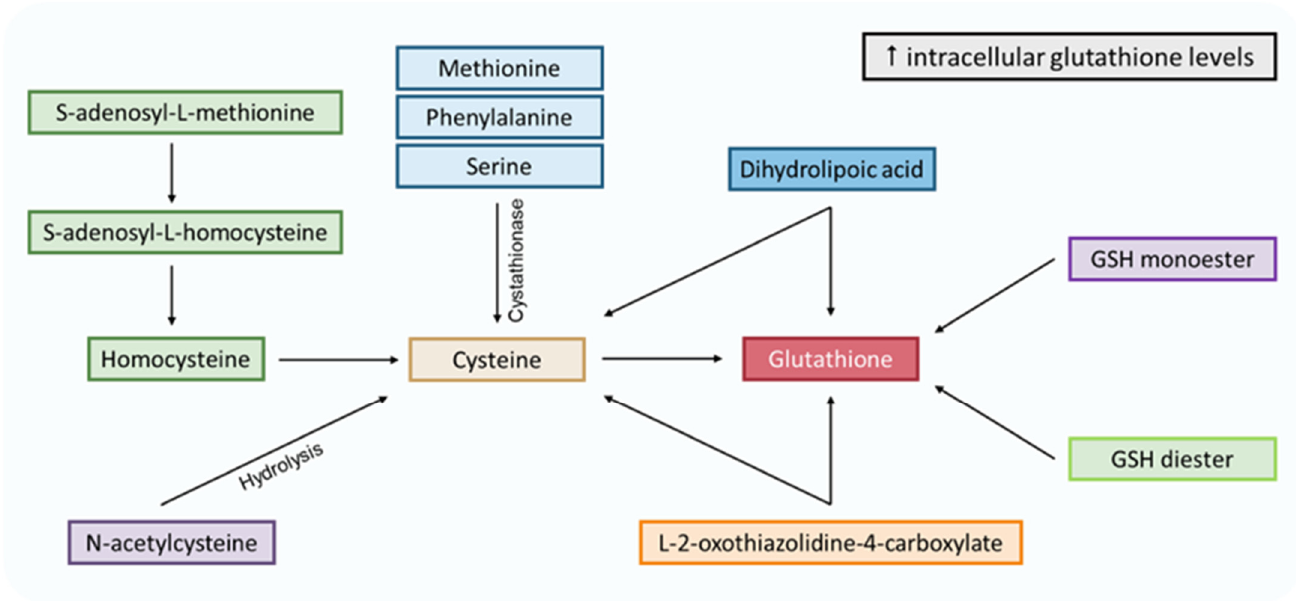
Figure 5. Pathways to increase intracellular levels of glutathione. Methionine, phenylalanine, serine and S-adenosyl-L-methionine are cysteine precursors through the transsulfuration pathway. N-acetylcysteine could be transformed into cysteine via hydrolysis. L-2-oxothiazolidine-4-carboxylate is an analog of 5-oxoproline (glutamate cycle form), which increases cysteine and glutathione intra- cellular levels. Dihydrolipoic acid comes from the α -lipoic acid reduction and can reduce glutathione and cysteine. The latter enters the γ -glutamyl cycle, where it stimulates glutathione synthesis. Finally, the GSH monoester and diester can be hydrolyzed to GSH.